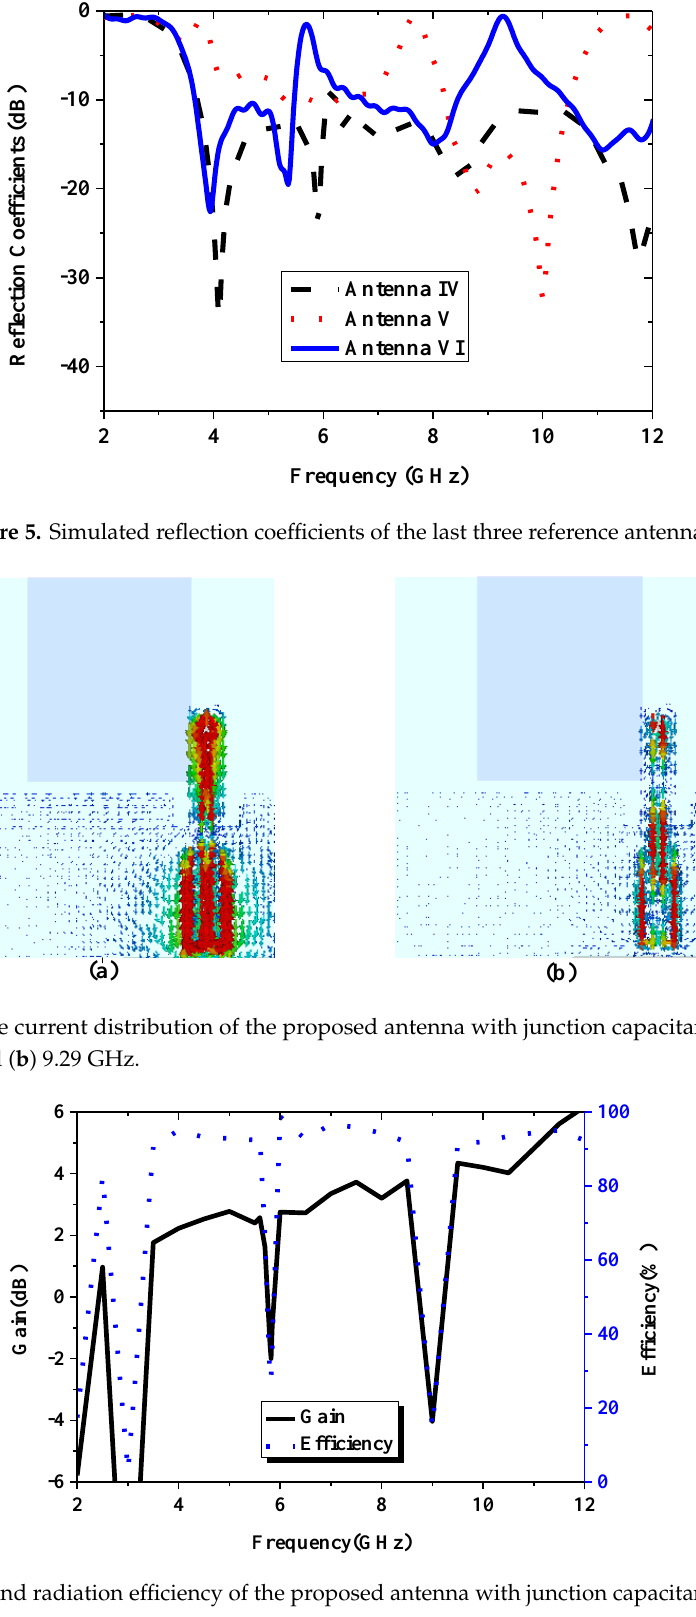
Figure 8. Simplified equivalent varactor Circuit. Table 1. Capacitance vs reverse voltage of SMV 1405-079LF. Vr (V)